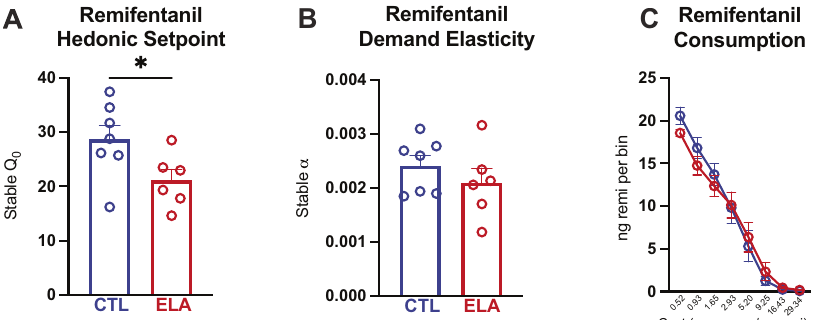
Fig. 4 ELA reduces hedonic setpoint for opioids, but demand elasticity is preserved. A Hedonic setpoint or consumption at low effort is reduced by ELA. B Demand elasticity or motivation to obtain drug at high cost, is not changed by ELA. C Average consumption at each price. * ELA vs. CTL P < 0.05. n = 7 CTL/6 ELA. Heroin-induced neuronal activation Effects of ELA . ELA led to several changes in the pattern of heroin-induced Fos expression, when analyzed regardless of prior opioid experience. Speci fi cally, ELA blunted heroin-induced c-Fos expression in NAc core (Fig. 5C; t 27 = 3.108, P = 0.0044, η 2 = 0.2634) but not shell (Fig. 5C; t = 0.8425, P = 0.4069). In 27 contrast, ELA increased heroin-induced Fos expression in CeA (Fig. 5A; t 27 = 3.188, P = 0.0036, η 2 = 0.2734) and PFC (Fig. 5C; t 27 = 2.675, P = 0.0125, η 2 = 0.2095). The selectivity of these effects of ELA are apparent from the lack of changes in BLA (Fig. 5C; t 27 = 0.4239, P = 0.6750) or PVT (Fig. 5C; t 27 = 0.4901, P = 0.6280). ( F 1,39 = 3.420; P = 0.0720; η p2 = 0.0806). Notably, ELA reduced the hedonic setpoint only in males (ELA vs CTL: males P = 0.0207; females P = 0.9341). For demand elasticity ( α ), there was a main effect of rearing condition across the sexes ( F 1,39 = 4.328, P = 0.0441, η p 2 = 0.0999), though this effect survived post hoc multiple comparison correction only in females (ELA vs CTL: females P = 0.0105; males P > 0.999). There was no signi fi cant effect of sex on α ( F 1,39 = 2.064; P = 0.1588) and no experience: F (1,25) = 11.28, P = 0.0025, η p2 = 0.3109). There was sex x rearing condition interaction ( F 1,39 = 1.356; P = 0.2513). These comparisons are thus consistent with, though do not prove, the 0.7516). The main effect of rearing condition described above testable hypothesis that ELA differentially affects opioid reward in persisted in this analysis: F (1,25) = 8.868, P = 0.0064, η p2 = 0.2618). males and females. In NAc shell, ELA rats trended toward having lower Fos when